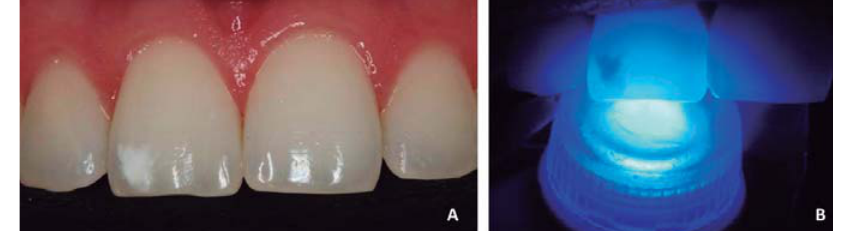
Figure 6- A: Patient with white spots; B: A method that can be used to try to see how deep the white spot in the enamel is to apply a LED source on the palatal surface and turn it